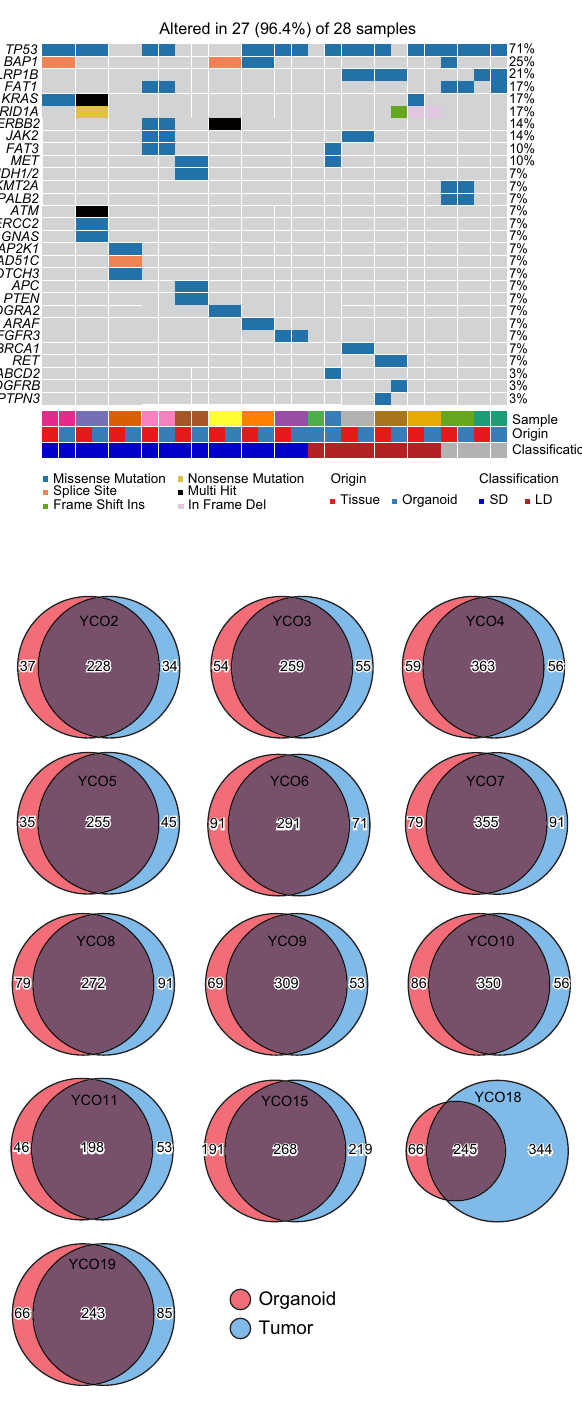
( n =13). d The concordance (%) between the cancer-related variants found in the tumor of origin and the corresponding tumor organoids is shown by bar plots. Tissue-speci fi c or organoid-speci fi c mean that the cancer-related variants are dis- cordant and not shared ( n